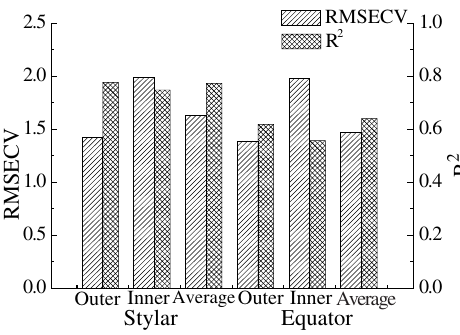
Fig. 5. Calibration statistic of SSC models using di®erent spectra collecting method.